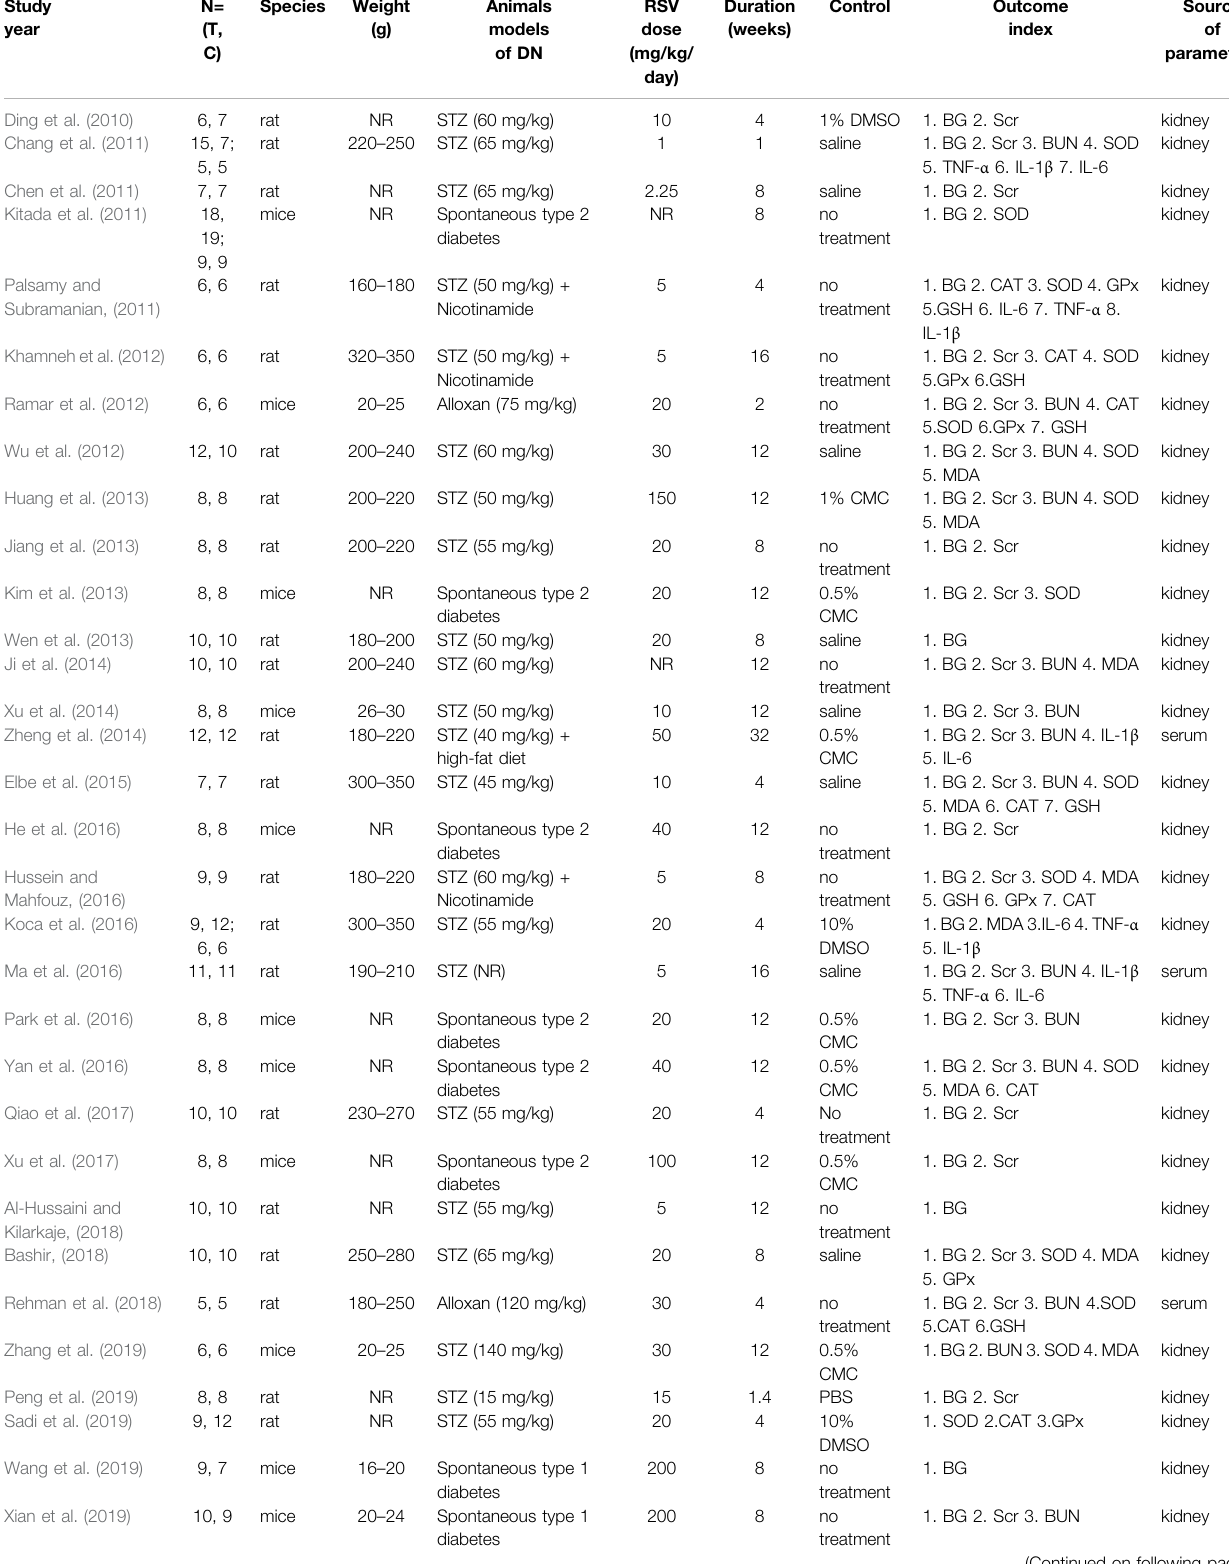
TABLE 1 | Characteristics of the included